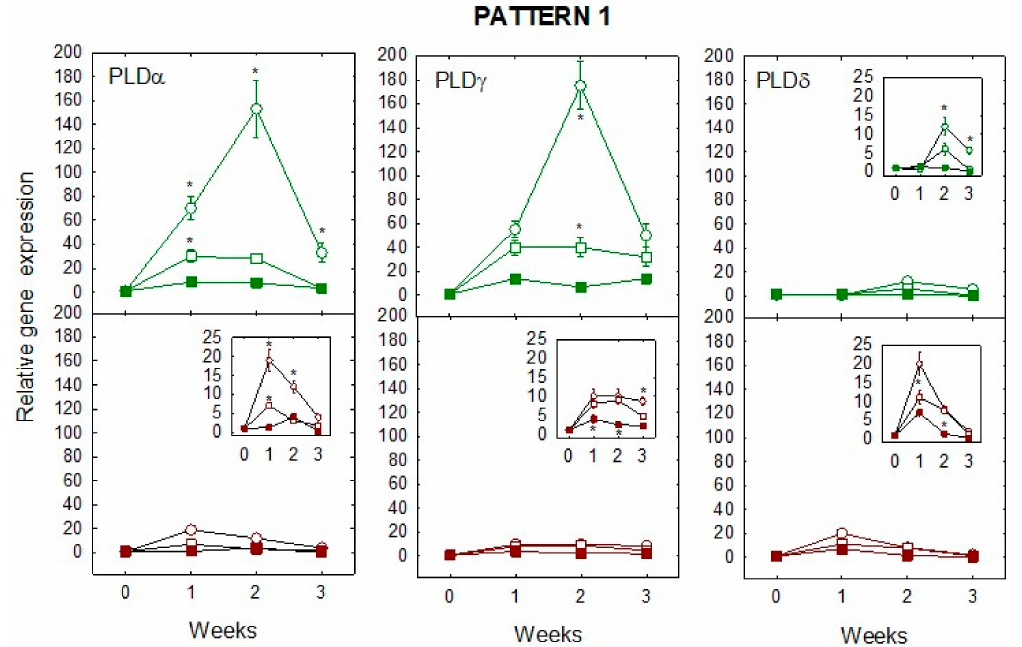
Figure 4. E ff ect on relative gene expression of di ff erent conditions of water stress (severe drought (0% ET, O), mild drought (50% ET, (cid:3) ), and fully watered plants (100% ET, (cid:4) )) in leaves (upper panels) and roots (lower panels) of ‘Pineapple’ sweet orange trees during a 3-week period. Pattern 1: Expression of CsPLD α , CsPLD γ , and CsPLD δ . Inset panels show magnified scale to appreciate di ff erences. Data are means ± SE of three biological replicates. Asterisks indicate significant di ff erences at * p <